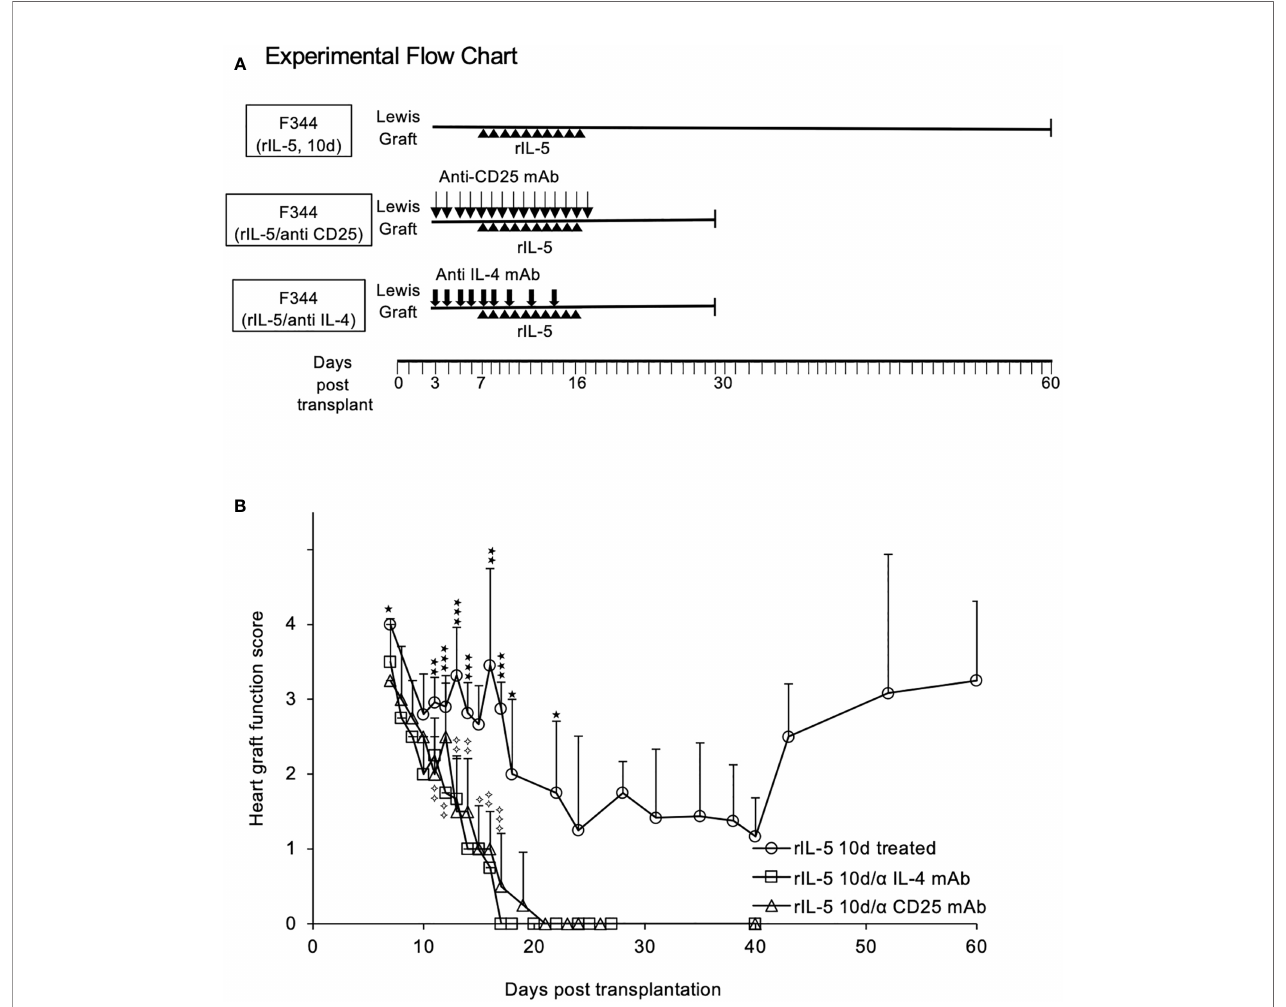
FIGURE 4 | Blocking IL-4 or depleting CD25 + cells prevents rIL-5 treatment inhibiting rejection of Lewis heterotopic heart allografts in F344 recipients. (A) Experimental Flow Chart. All groups received 5000 units of rat rIL-5 daily (ipi) in 0.5ml. One group was treated with anti-CD25 mAb (NDS61) (n=4) and another